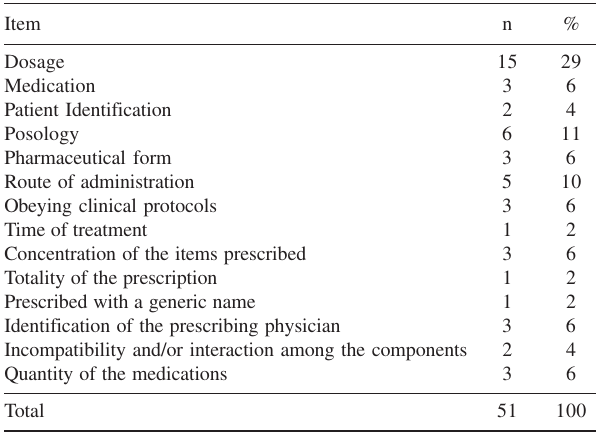
Table 3 - Distributions of the items analyzed in the medical